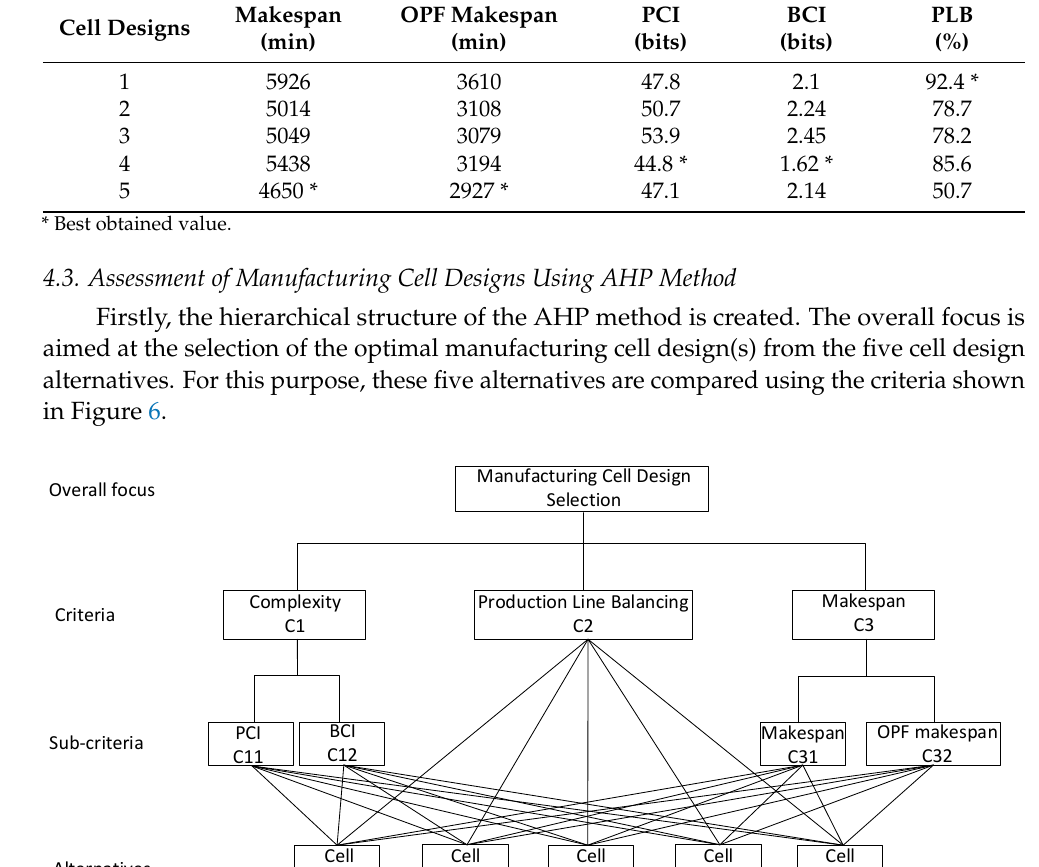
Table 2. Enumerated results of all the criteria and sub-criteria.